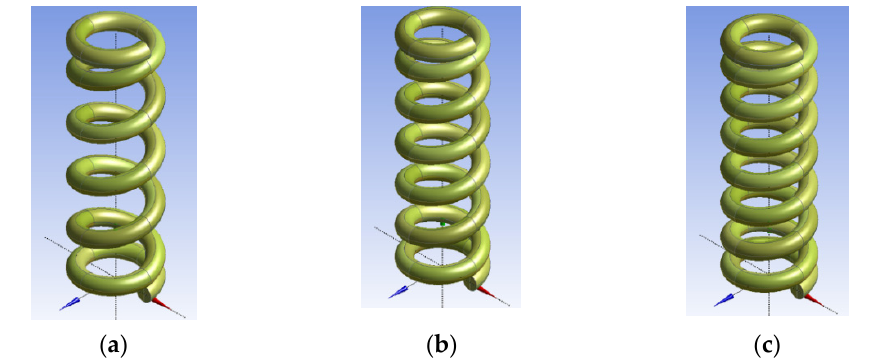
Figure 5. SCDs according to the number of active coils: ( a ) 4; ( b ) 5; ( c ) 6.